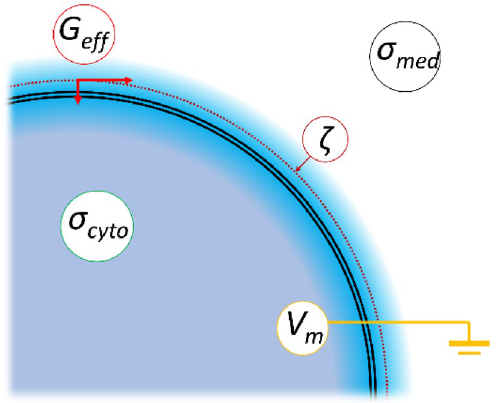
Figure 1. A schematic showing some of the parameters and variables used in this study. Parameters σ med and σ cyto represent the medium conductivity and cytoplasm conductivity respectively; membrane potential V m represents the electrical potential inside the cell with respect to the bulk medium; ζ is the zeta-potential at the hydrodynamic plane of shear; and G eff is the effective membrane conductance which comprises both transmembrane and double-layer